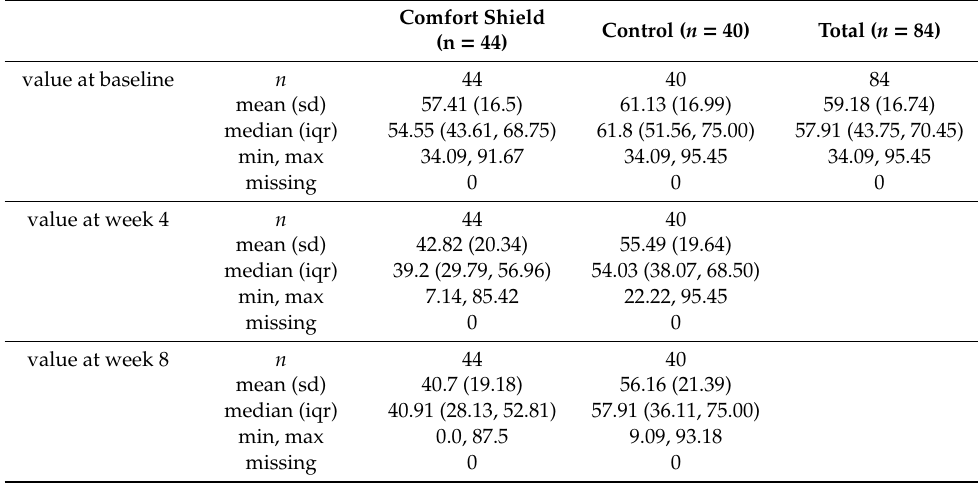
Table 6. Ocular surface disease index (OSDI): value at baseline and at each post-baseline visit—PPS ( n = 84)—descriptive analysis, by group.